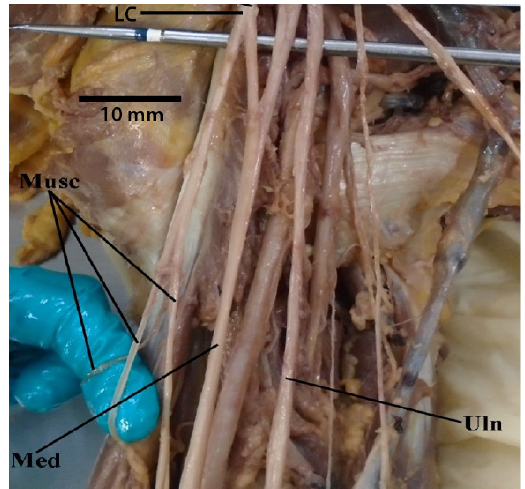
Figure 5. Photograph of multiple proximal branches of the musculocutaneous nerve. Abbreviations: LC = lateral cord; Med = median nerve; Musc = musculocutaneous nerve; Uln = ulnar nerve. The remaining three branching patterns were far less common and only observed one time each—a medial antebrachial cutaneous nerve arising from the medial cord’s con- tribution to the median nerve, a crisscrossing connection between the medial and lateral cords proximal to the “M,” and the fusion of medial and lateral cords proximal to the “M”.